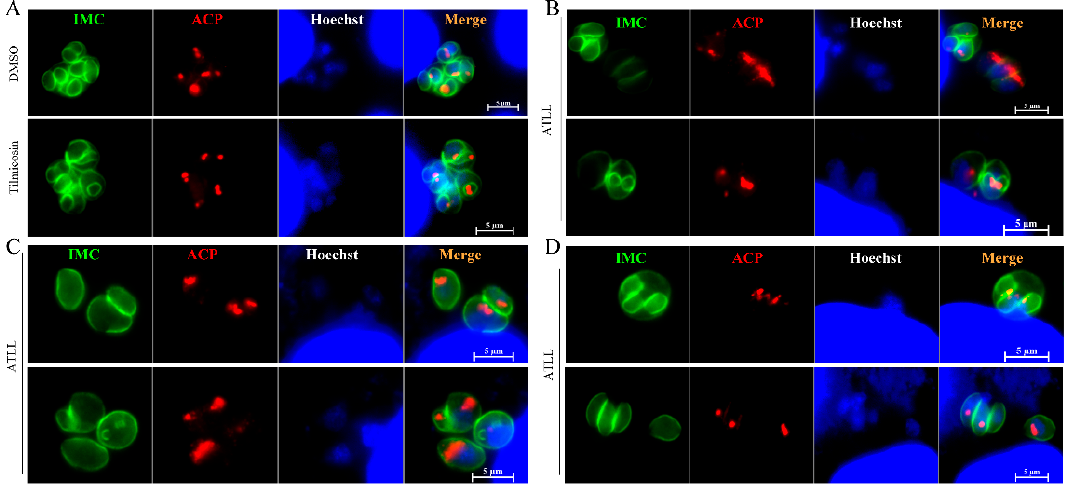
Figure 6. Effects of ATLL on the division of tachyzoites. 1 × 10 5 tachyzoites were used to invade HFF monolayers seeded on cover slips and then treated with DMSO, tilmicosin (26.94 μ M) ( A ) and ATLL (16 μ M) ( B – D ) at 37 °C in 5% CO 2 for 20 h, respectively. The division of tachyzoites was observed by IFA using rabbit anti-IMC1 antibody, mouse anti-ACP antibody and Hoechst dye.